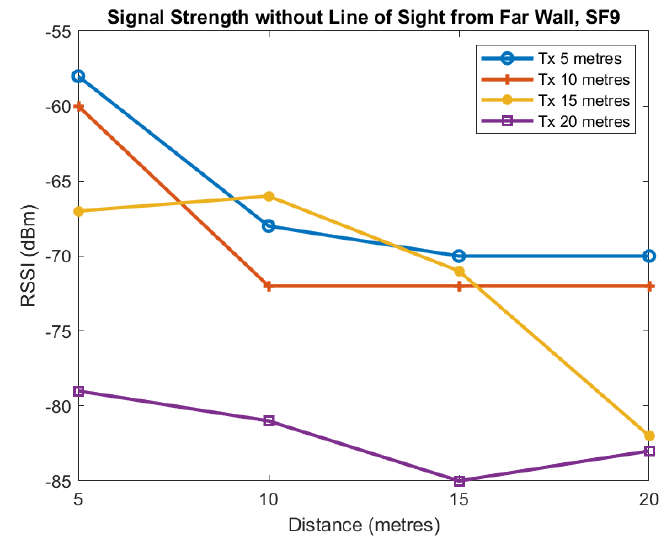
Figure 20. RSSI against receiver distance from junction for different transmitter distances from junction, Far-Wall,